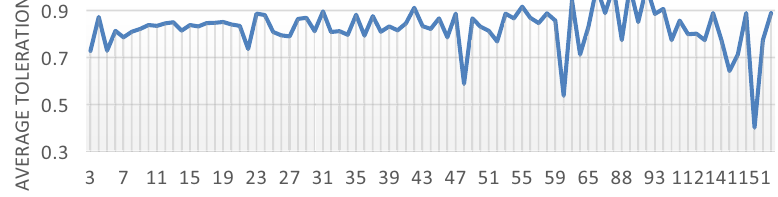
Figure 14. Average